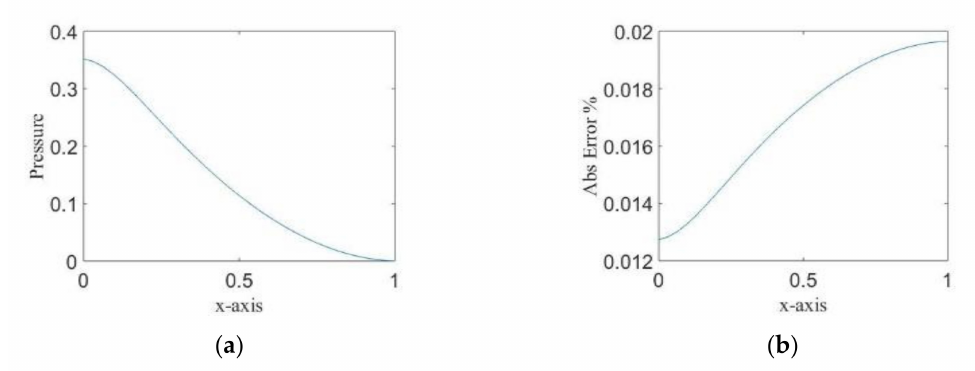
Figure 3. ( a ) The pressure mean solution using MC method. ( b ) The percentage of di ff erence of solutions between MC and PCE methods.